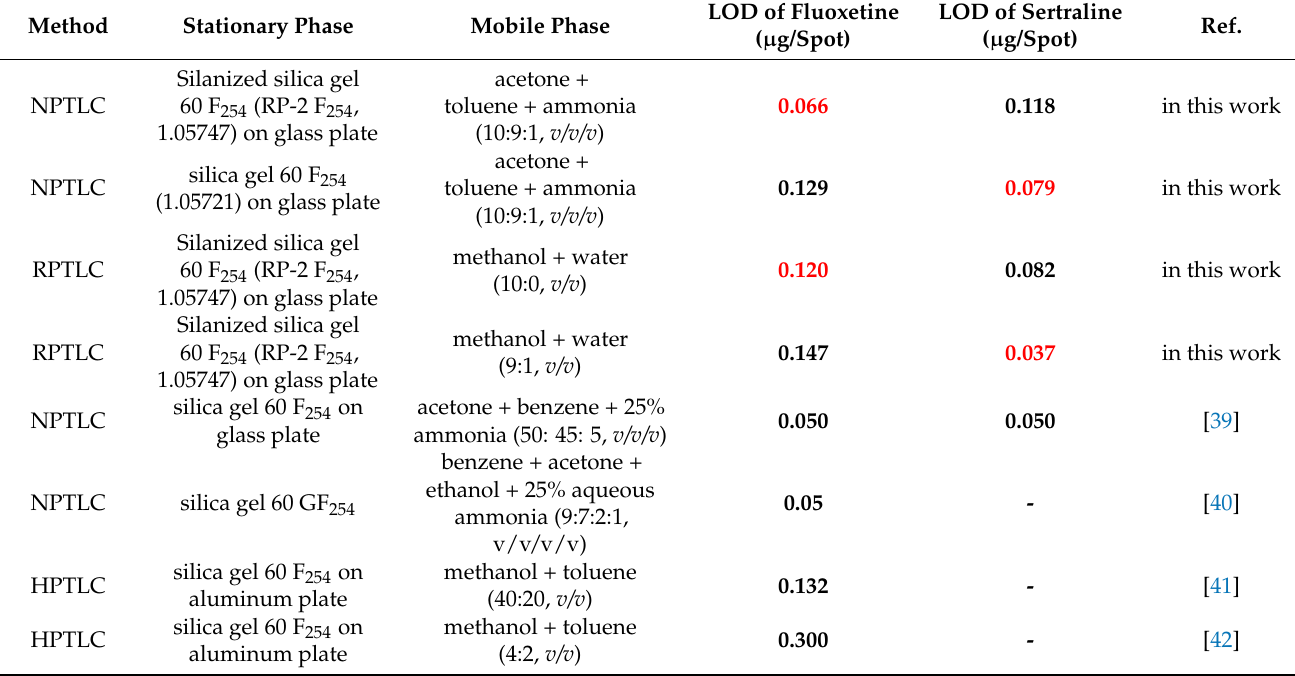
Table 1. Summary of the lowest LOD values of fluoxetine and sertraline (marked in red) obtained during the study using the NPTLC and RPTLC techniques with the literature